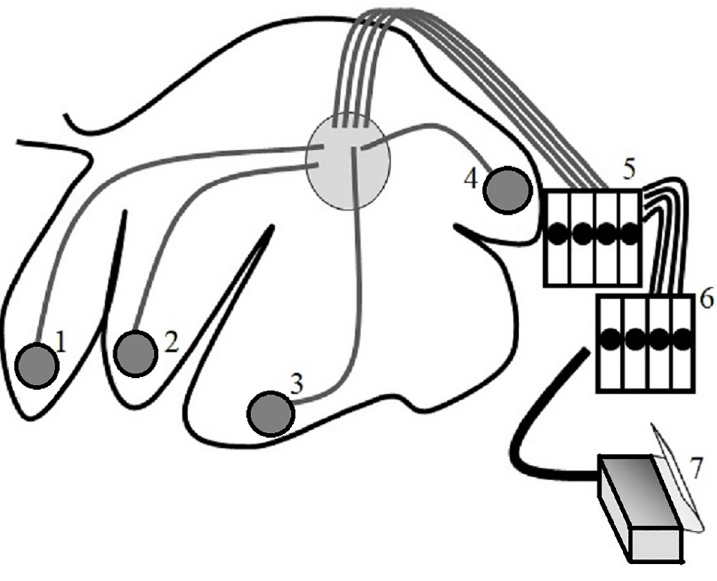
Fig 2. Schematic overview of the measurement device. (1) Reticulum (2) cranial sac of the rumen (3) ventral sac of the rumen (4) dorsal sac of the rumen (5) pressure transducers (6) amplifier (7) computer.